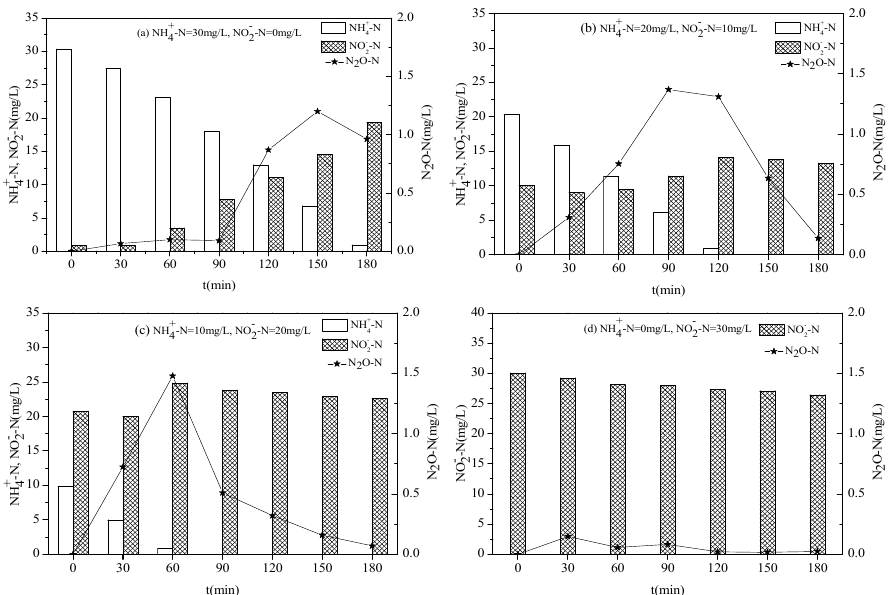
Figure 2. N 2 O emission during partial nitrification (partial nitrification effluent +NH 4 Cl-N/NaNO 2 - N, DO = 0.5 mg/L).